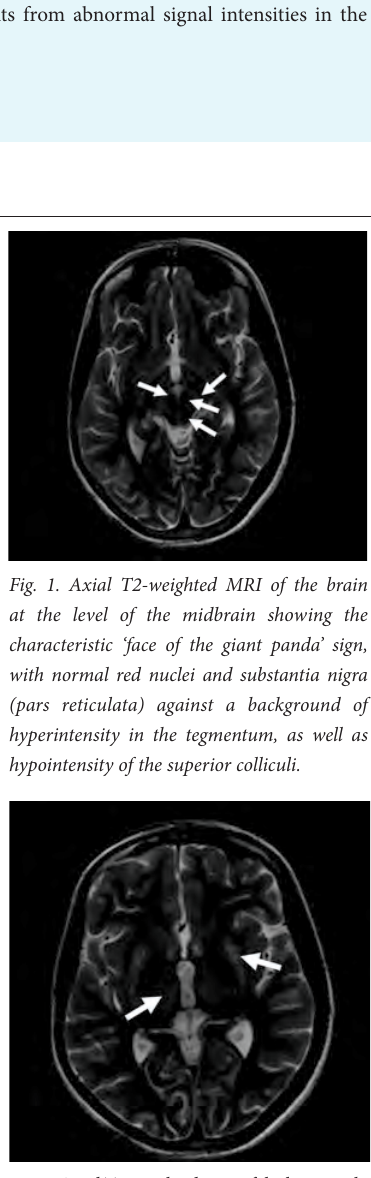
Fig. 2. Axial T2-weighted MRI of the brain at the level of the basal ganglia showing hyperintensity in the putamina and thalami (white